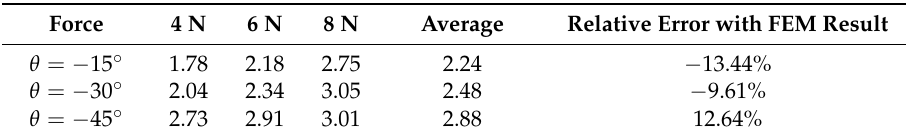
Table 3. Experimental results of the vibration level difference under different exciting forces with the cell thickness t = 2 mm (dB).